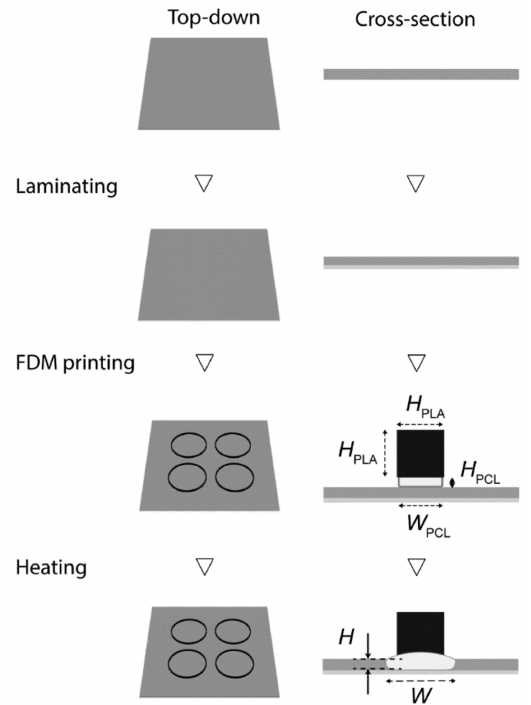
Figure 1. Schematic illustration of the fabrication of 3D-paper-based analytical devices (PAD). Firstly, the filter paper was laminated on the bottom side. The circular base was then printed with polycaprolactone (PCL), and the wall was printed with polylactic acid (PLA). The entire device was placed in the oven and heated at 150 ◦ C for 60 min for the thermal reflow of